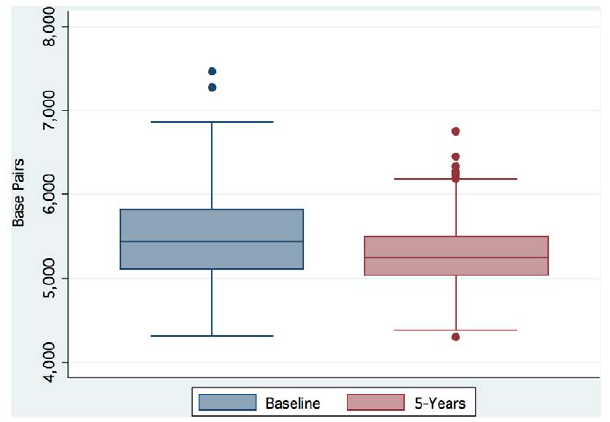
Figure 1. Distributions of baseline and follow-up leukocyte telomere length.